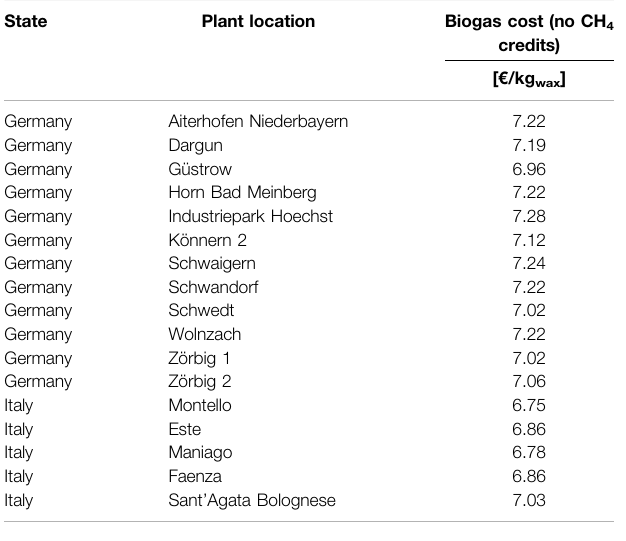
TABLE 6 | Preferential plant location in Germany and Italy. The cost of wax production does not consider the capture unit installation costs and biomethane grid injection